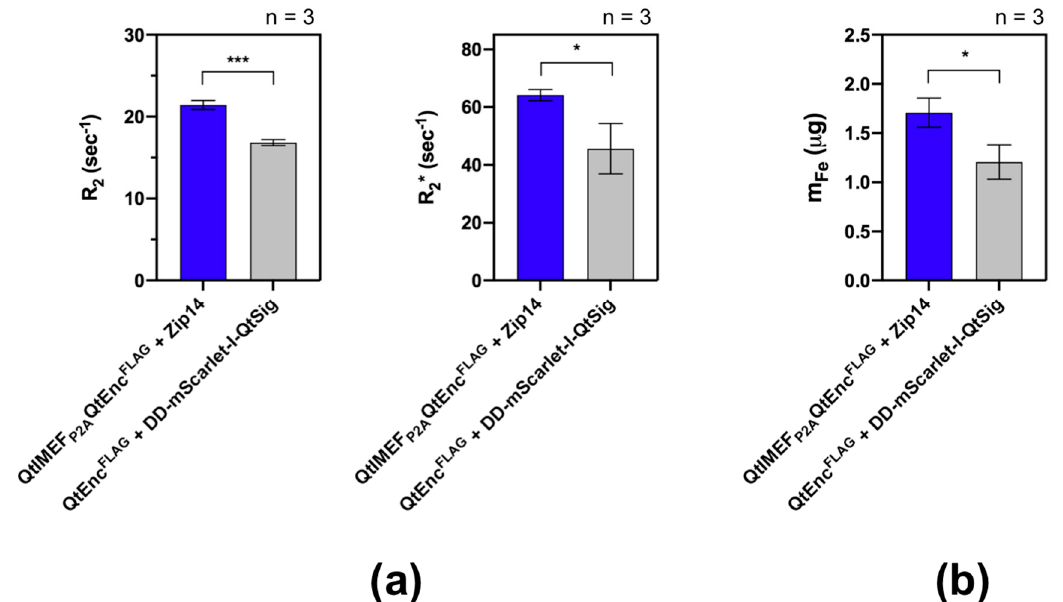
Figure 3. MRI relaxometry of the HepG2 cells transiently expressing the constructs as indicated in the figure and cultivated in the medium supplemented with 2 mM FAS for 24 h. ( a ) R 2 and R 2 * values were computed from cell pellets comprising ~8 × 10 6 cells. ( b ) Fe masses in the same cell pellets determined by inductively coupled plasma mass spectrometry (ICP-MS). All numbers are plotted as mean values ± SD ( n = 3). Statistical analysis was performed by unpaired t -test (*** corresponds to p -value < 0.001, * corresponds to p -value < 0.05).